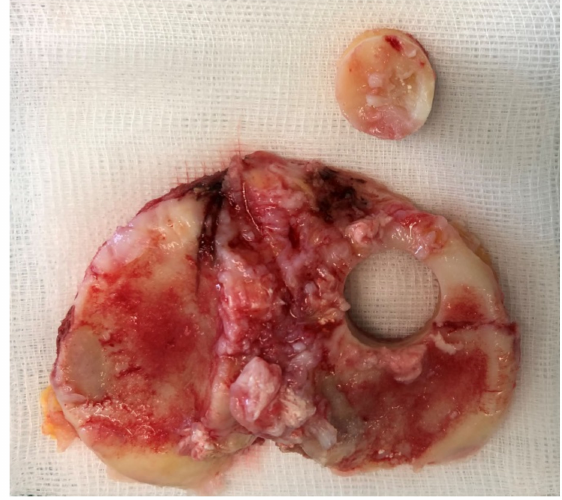
Figure 3. Bone cylinder harvested from tibia plateau.